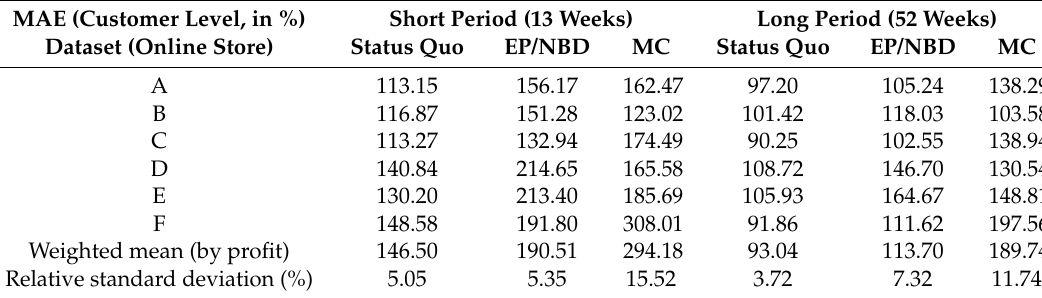
Table 5. Results for MAE (customer-level, in %).